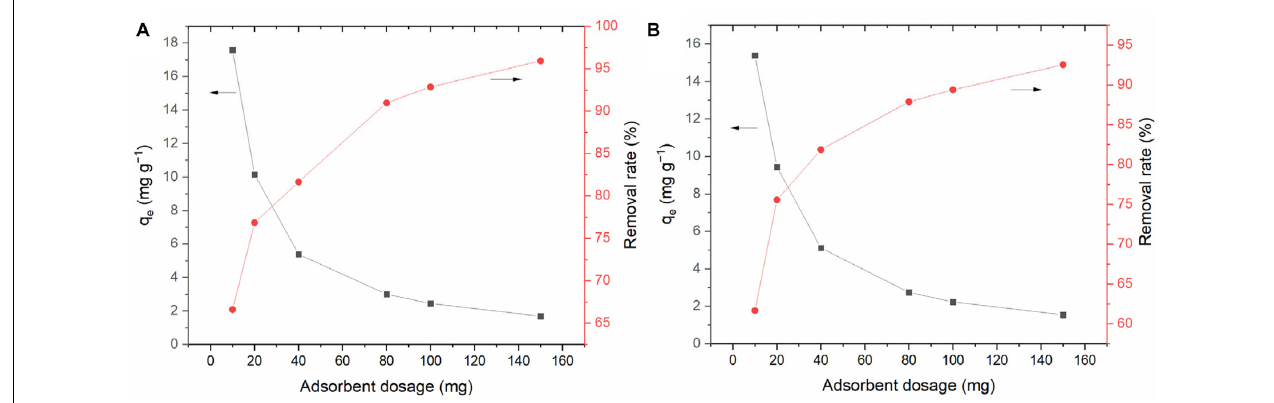
FIGURE 7 | Effect of adsorbent (BC/MnO 2 ) dose on adsorption efficiency: (A) tetracycline hydrochloride, (B) doxycycline.